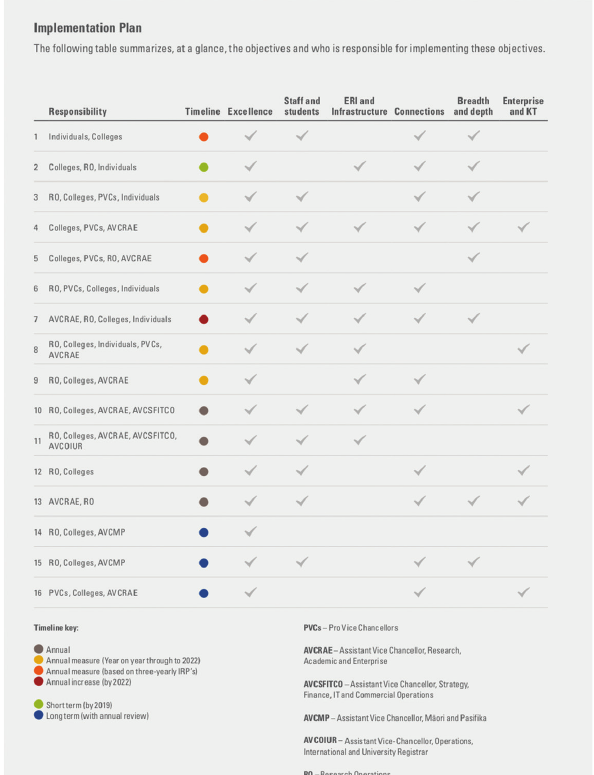
Figure 1. Implementation plan for Massey University’s strategic plan, including enterprise and knowledge transfer (KT) in the far-right column (Source: Massey University, Research Strategy